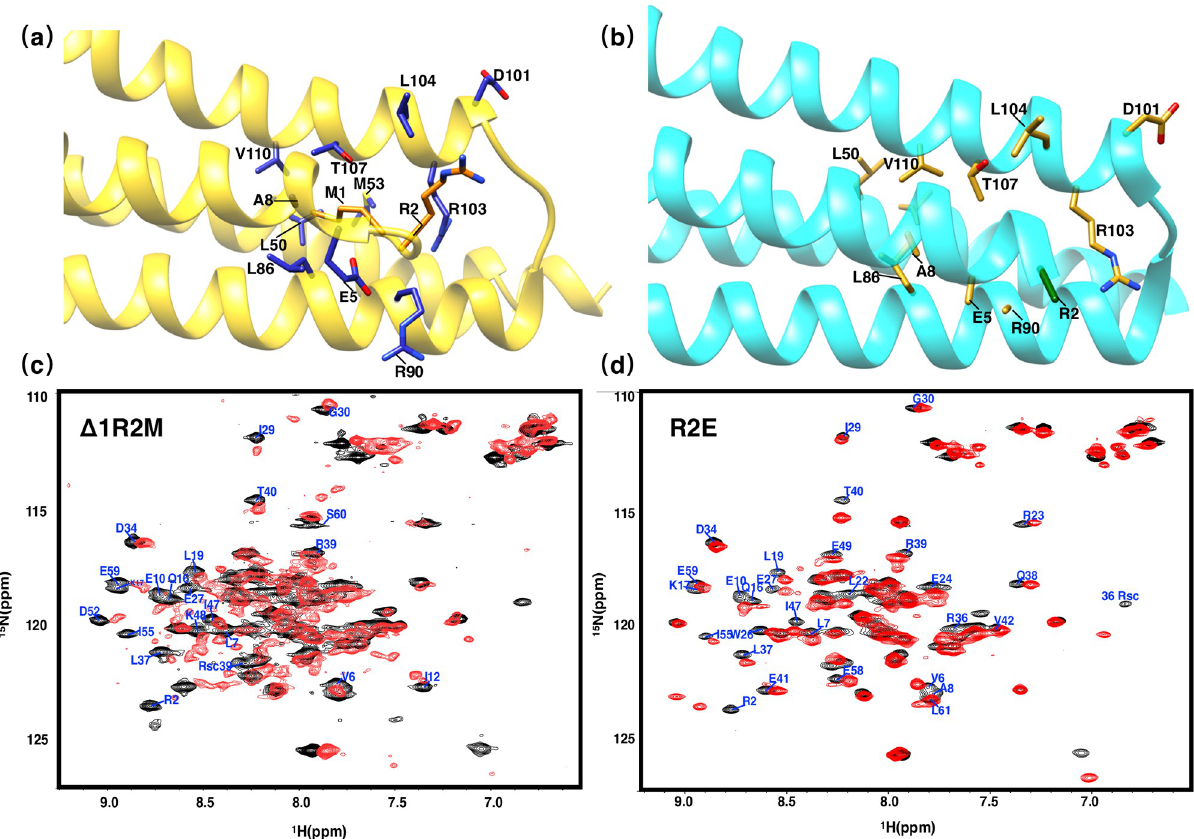
Fig 6. Two-dimensional 1 H - 15 N HSQC spectra of Δ 1R2M and R2E. Ribbon representation of the (a) solution structure (gold) and (b) crystal structure (cyan) with the side chains M1 and R2 in orange and green, while the side chains of the residues interacting with M1 or R2 are shown in blue and mud yellow for solution and crystal structures, respectively. (c) Two-dimensional 1 H - 15 N HSQC spectra of Δ 1R2M. (d) Two-dimensional 1 H - 15 N HSQC spectra of R2E, residues experiencing great chemical-shift changes ( Δ comp � 0.3 ppm) are labeled.